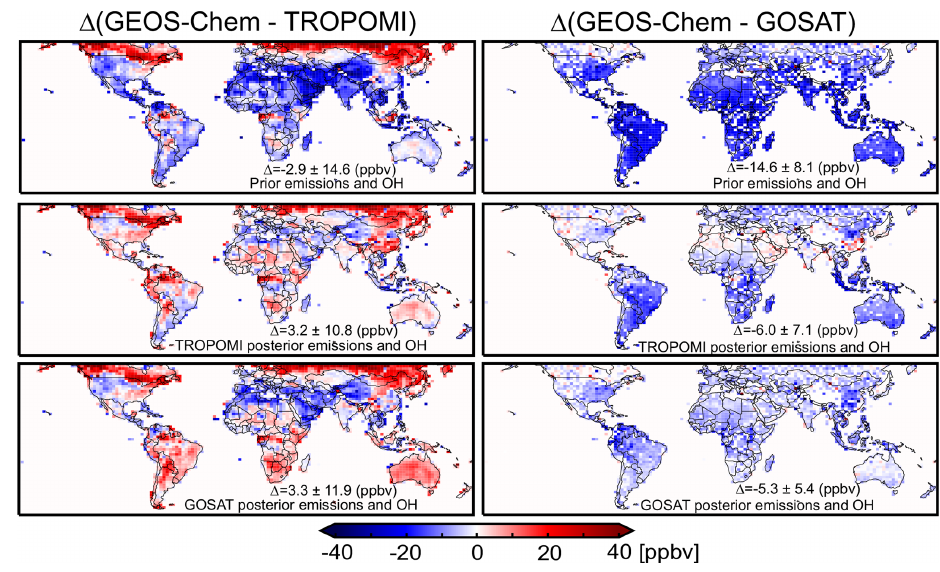
Figure 6. Comparison of GEOS-Chem X CH to TROPOMI and GOSAT observations. Panels show annual mean differences for 2019 between 4 the GEOS-Chem simulation and observations, with mean bias ± standard deviation given in the inset. The top panels show GEOS-Chem with prior emission and OH estimates. The middle panels show GEOS-Chem with posterior estimates from the TROPOMI inversion. The bottom panels show GEOS-Chem with posterior estimates from the GOSAT